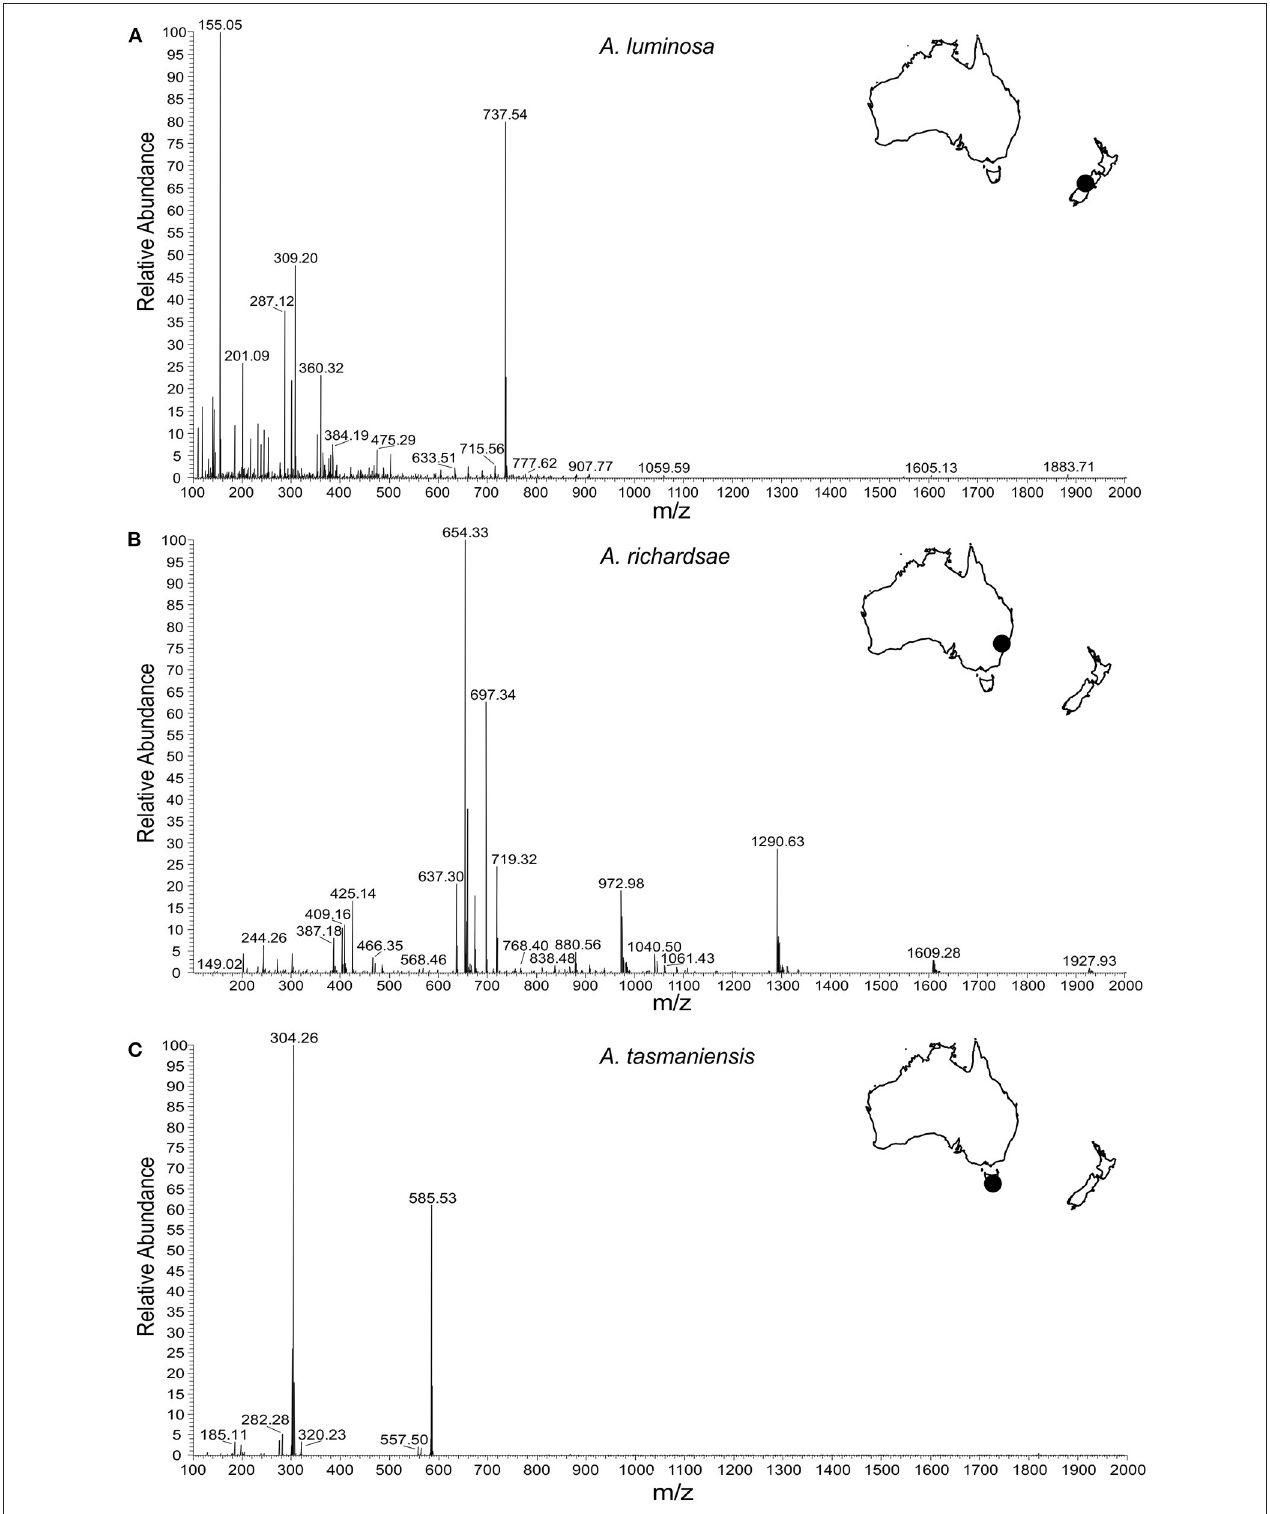
FIGURE 2 | Positive ion nanospray (ESI) high resolution mass spectrometry analysis of glowworm adhesives. (A) Spectrum of isolate from New Zealand glowworms ( A. luminosa , South Island). (B) Spectrum of isolate from Australian glowworms ( A. richardsae from Newnes, NSW). (C) Spectrum of isolate from Tasmanian glowworms ( A. tasmaniensis